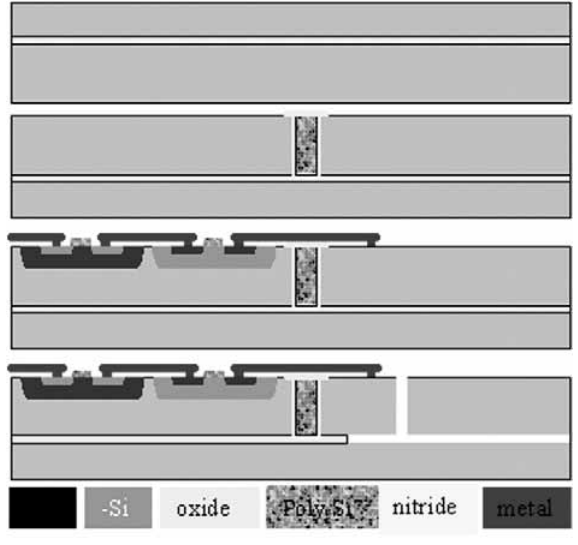
Fig. 1. Simplified SOI-MEMS process